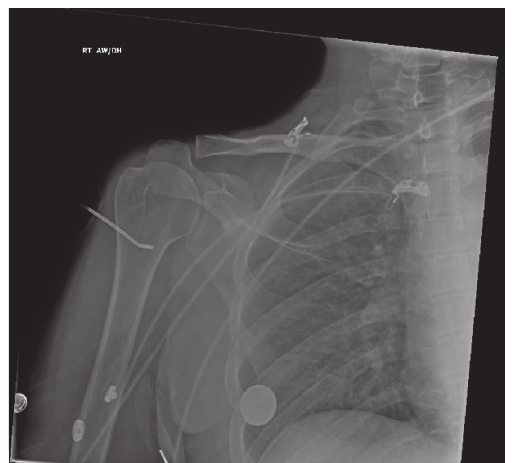
Figure 1: Radiograph of the right shoulder with a bent intraosseous needle in the neck of the humerus.